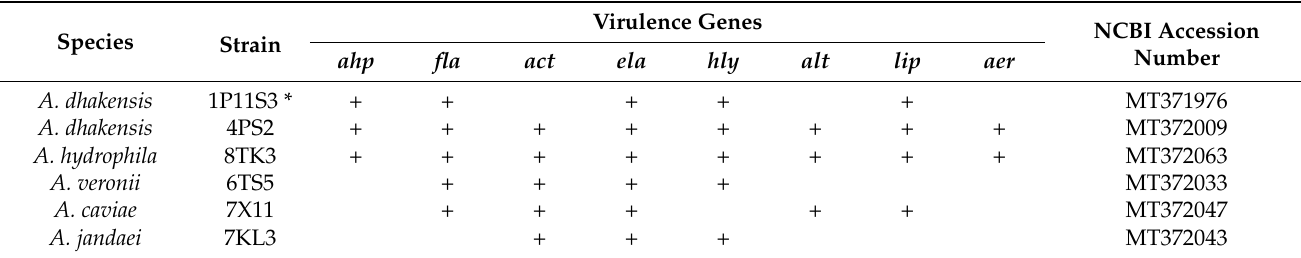
Table A1. Summary of virulence genes identified in each selected Aeromonas isolates that were conducted in the previous study (Azzam-Sayuti et al.,